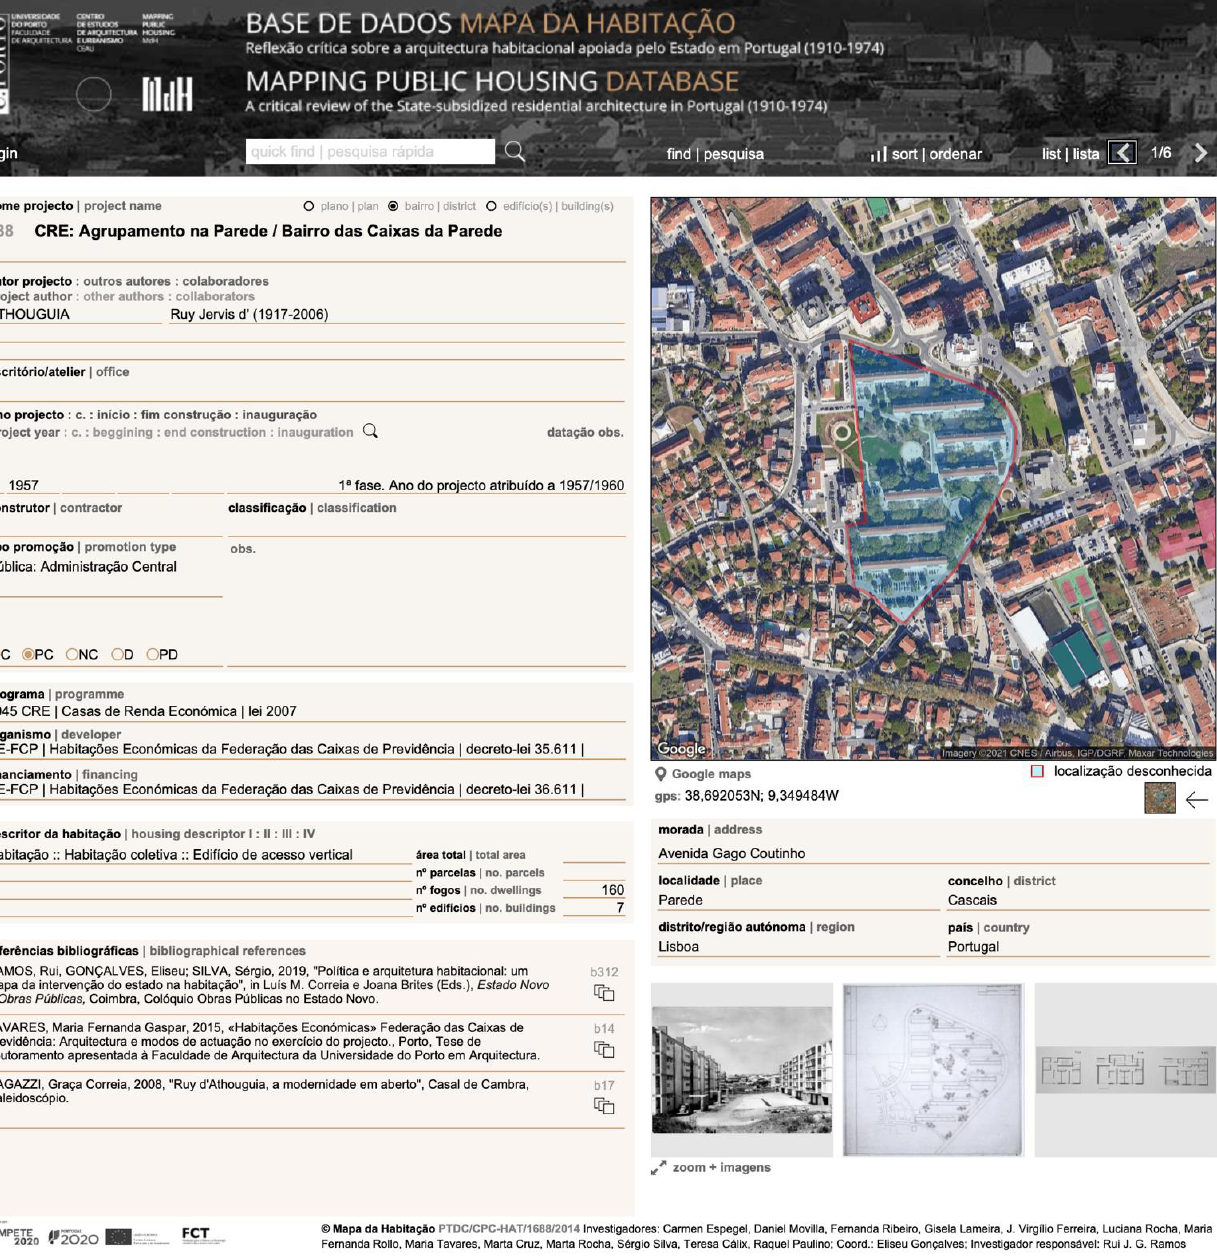
Figure A2. Partial view of the neighbourhood record (MdH DB a88). Source: MdH database, 2019.